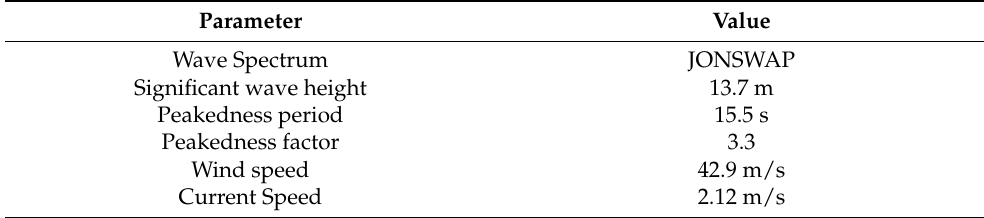
Table 5. Environmental parameters of 100 yr sea scenario